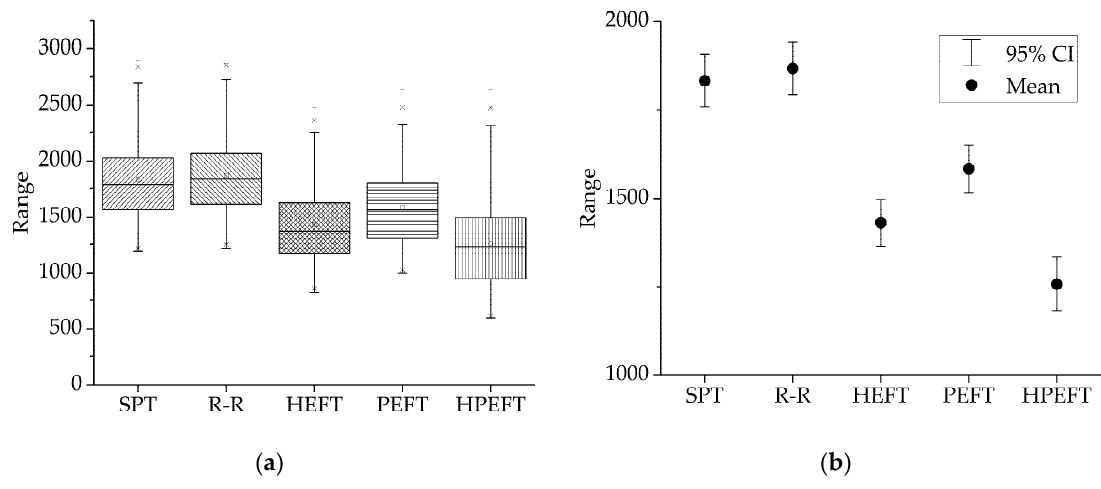
Figure 11. Statistical plots: ( a ) box plot and ( b ) 95% CI plot.